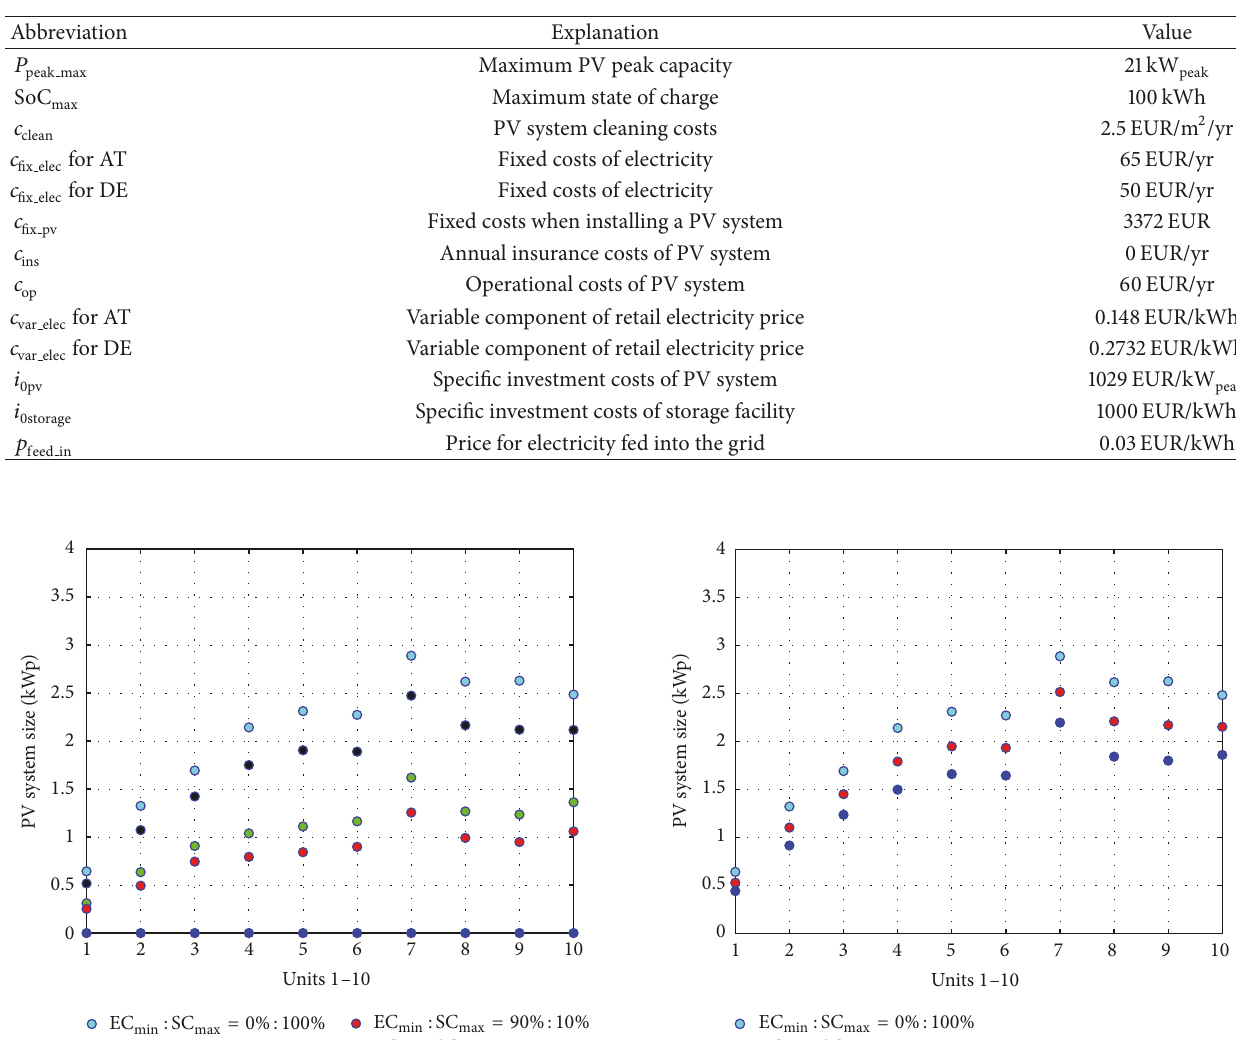
Table 1: Value assumptions.